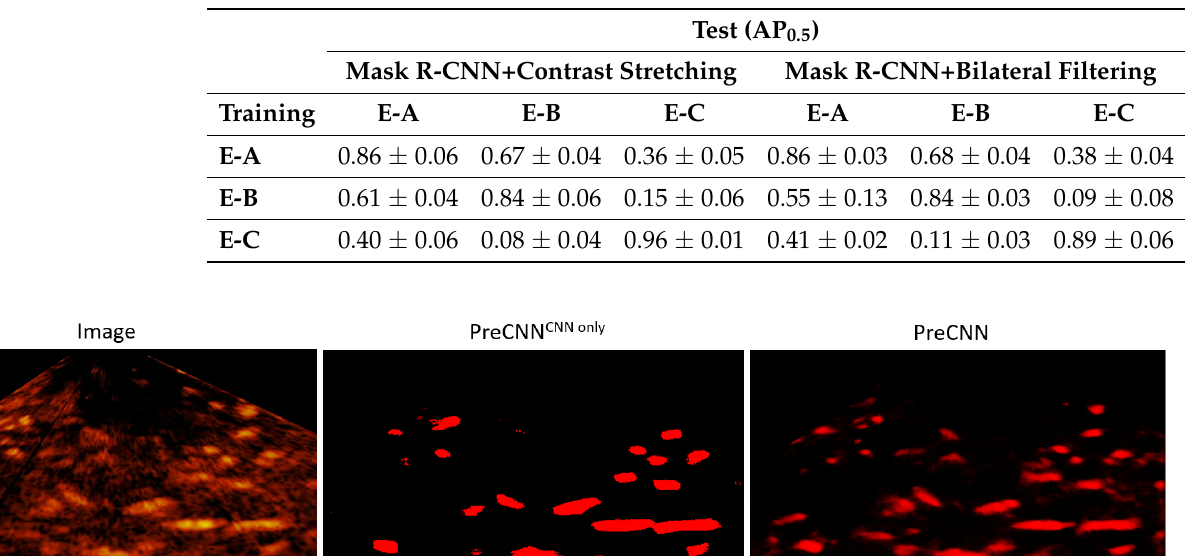
Table 3. The AP 0.5 of Mask R-CNN with image preprocessing.